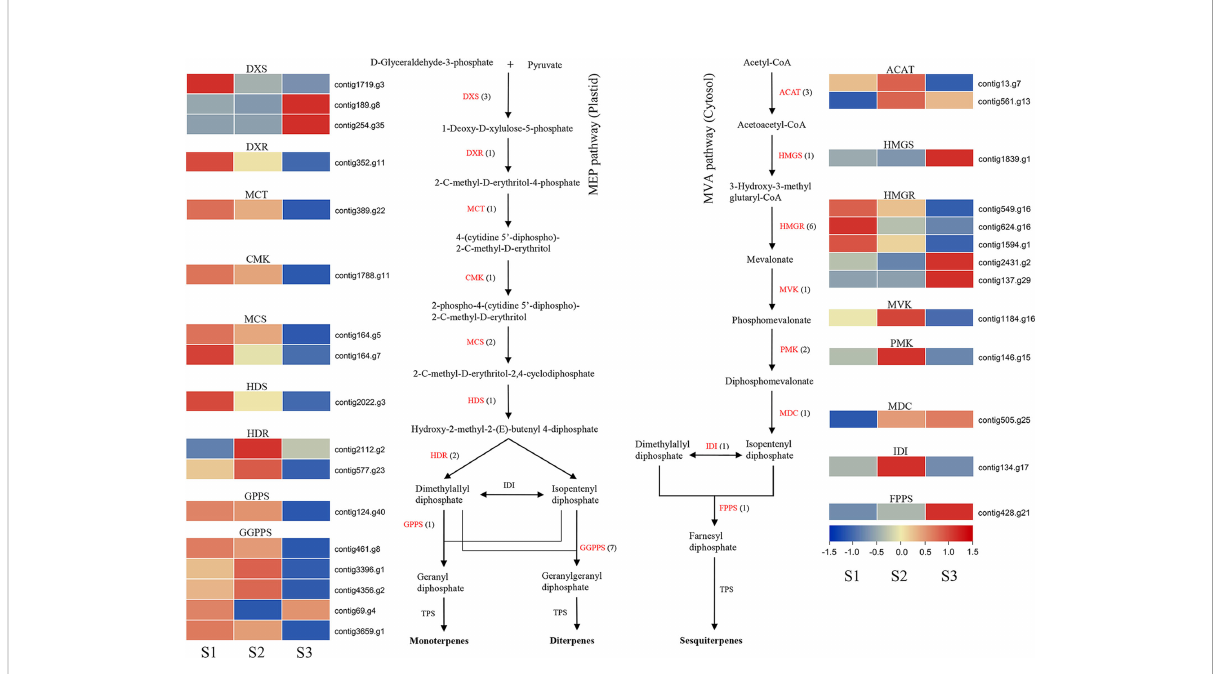
FIGURE 4 Expression pro fi les of genes encoding enzymes involved in terpene biosynthesis in J. sambac cultivar JSDB. Abbreviations for enzymes in each catalytic step were shown in red letters. The black numbers in parentheses represent the gene number in J. sambac genome. The gradient color for each gene represented the gene expression levels at three fl oral developmental stages (S1, young fl oral bud stage; S2, mature fl oral bud stage; S3, initial opening fl ower stage). DXS, 1-deoxy-D-xylulose 5-phosphate synthase; DXR, 1-deoxy-D-xylulose 5-phosphate reductoisomerase; MCT, 2-C-methyl-D-erythritol 4-phosphate cytidylyltransferase; CMK, 4-(cytidine 5 ′ -diphospho)-2-C-methyl-D-erythritol kinase; MCS, 2-C-methyl-D-erythritol-2,4-cyclodiphosphate synthase; HDS, 4-hydroxy-3-methylbut-2-en-1-yl diphosphate synthase; HDR, 4- hydroxy-3-methylbut-2-en-1-yl diphosphate reductase; GPPS, geranyl diphosphate synthase; GGPPS, geranylgeranyl diphosphate synthase; ACAT, acetyl-CoA acetyltransferase; HMGS, hydroxymethylglutaryl-CoA synthase; HMGR, hydroxymethylglutaryl-CoA reductase; MVK, mevalonate kinase; PMK, phosphomevalonate kinase; MDC, diphospho-MVA decarboxylase; IDI, isopentenyl diphosphate isomerase; FPPS, farnesyl diphosphate